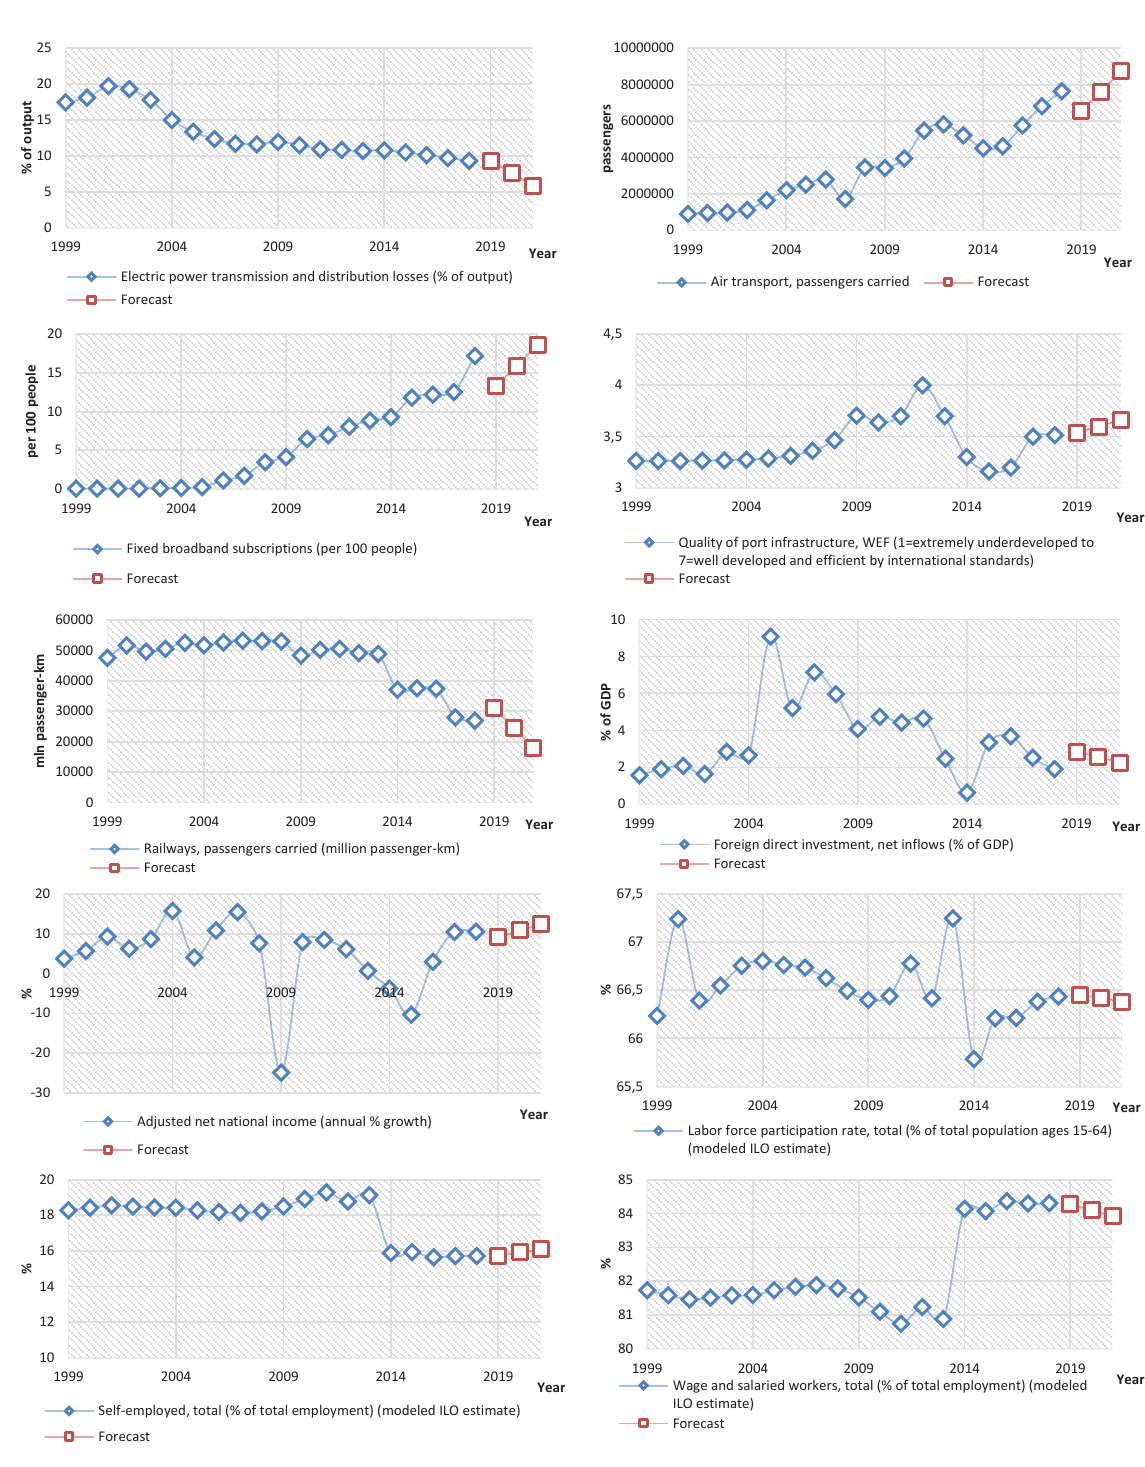
Figure B1. Graphical interpretation of retrospective and forecasted values of time series in terms of socio-economic conditions and infrastructure for